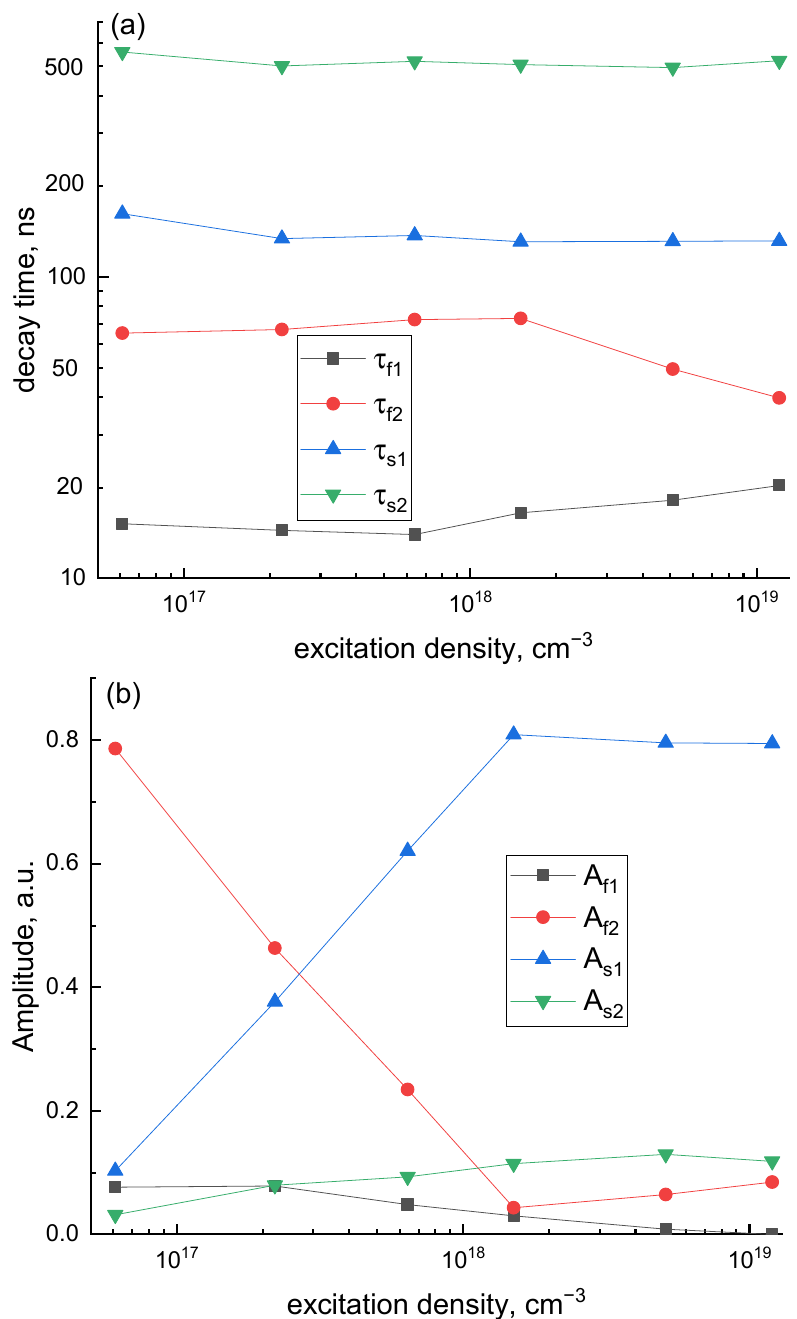
Figure 5. The dependence of the decay curves fitting parameters—decay times ( a ) and amplitudes ( b ) on the excitation density.